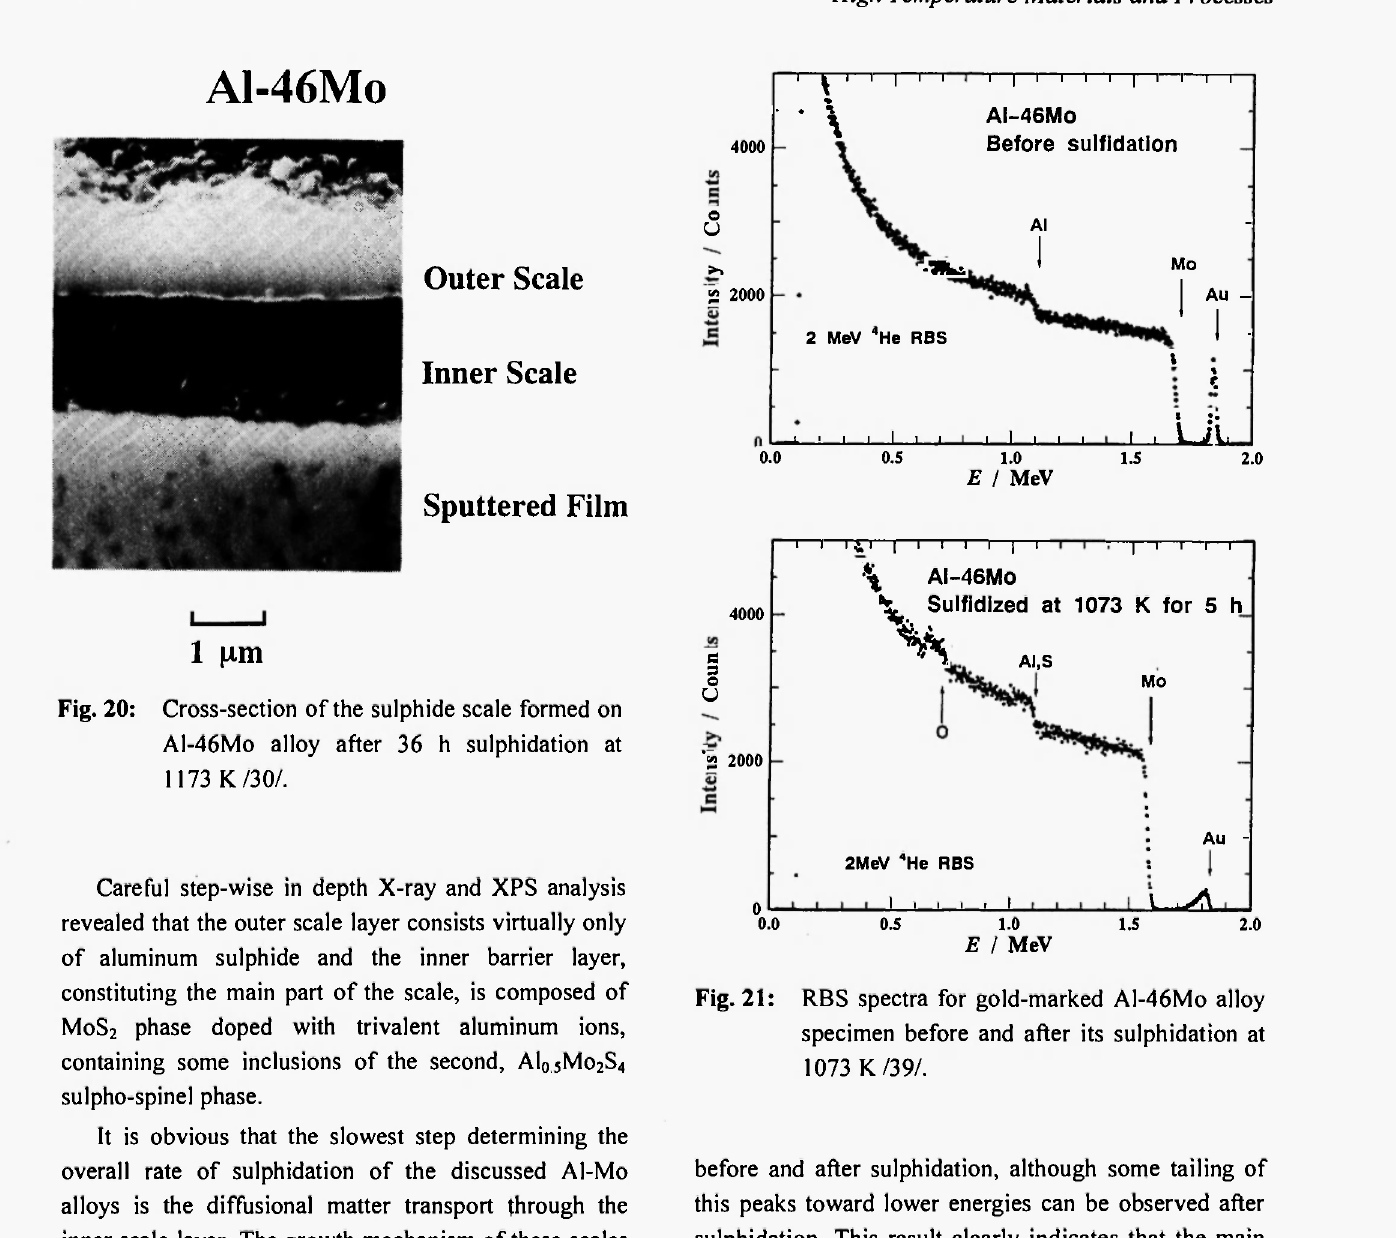
Fig. 20: Cross-section of the sulphide scale formed on Al-46Mo alloy after 36 h sulphidation at 1173 K/30/.